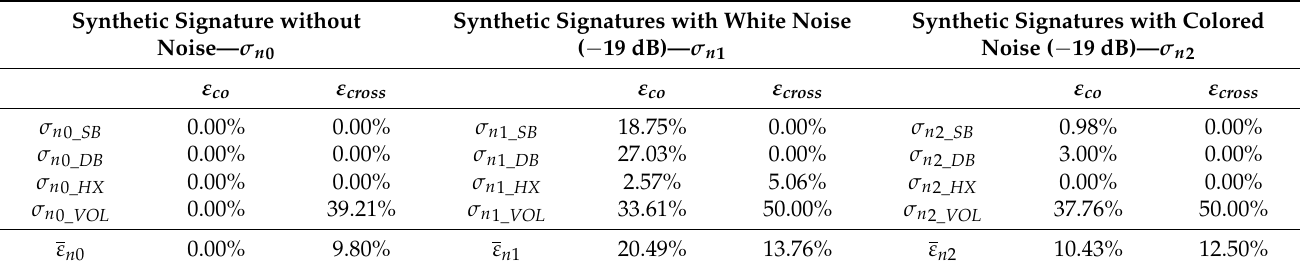
Table 4. Inaccuracies for the SIRT-based decomposition method revealed for synthetic signature recognition. Recognized signatures are specified in